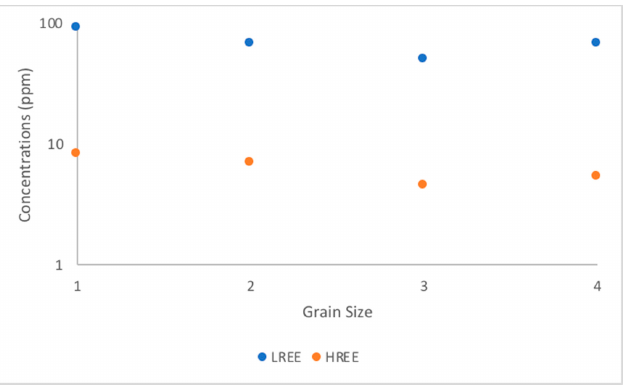
Figure 6. Grain size versus REE content of the fractions. 1: >4 mm , 2: 4–2 mm , 3: 2–1 mm , and 4: 1–0.063 mm.